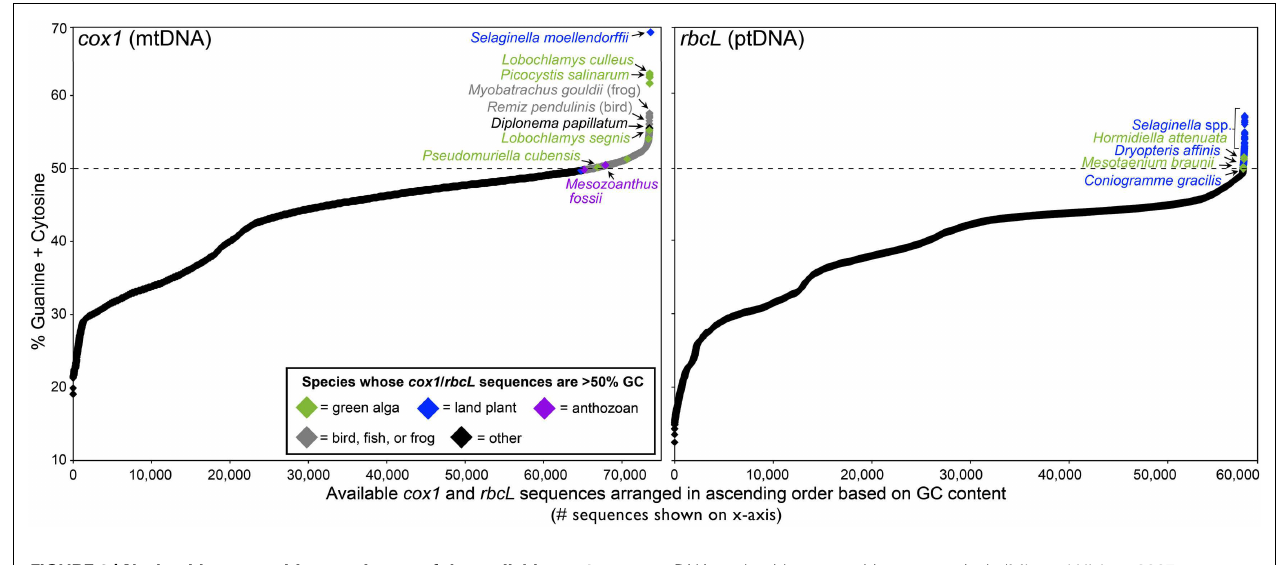
FIGURE 2 | Nucleotide composition continuum of the available cox1 and rbcL sequences from eukaryotic organelle genomes. The cox1 gene, which is located in the mitochondrial genome of all studied eukaryotes, encodes the protein cytochrome c oxidase subunit I.The rbcL gene, which is found in the ptDNA of most plastid-bearing eukaryotes, encodes the large subunit of Rubsico.The nucleotide content of cox1 and rbcL are good predictors of the overall mtDNA and